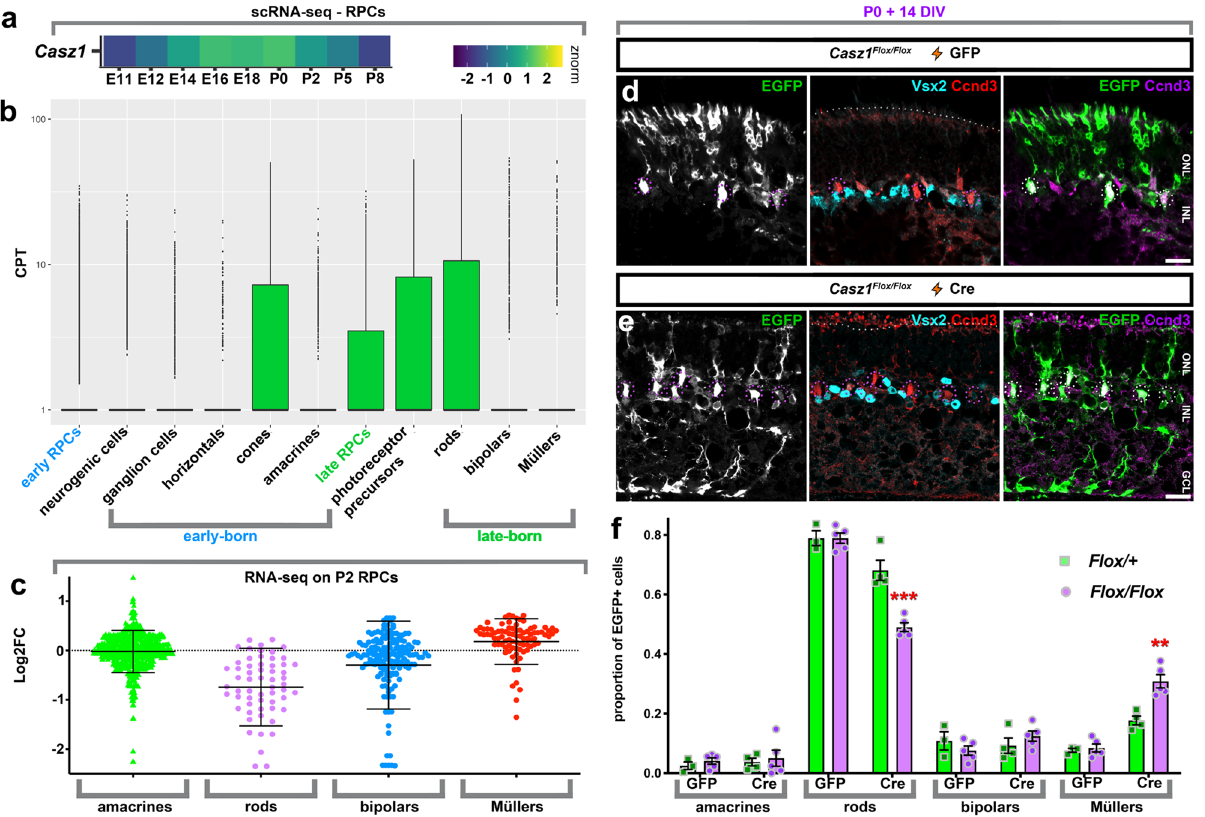
Figure 1. Casz1 controls the rod versus Müller glia fate decision in postnatal retinal progenitors. ( a,b ) reanalysis of scRNAseq expression data 3 . ( a ) Normalized Casz1 mRNA expression levels in RPCs during development. ( b ) Mean Casz1 mRNA expression (counts per 10 000 transcripts: CPT). ( c ) Re-analysis of previously published RNA-seq data from sorted P2 Casz1 cKO vs. control RPCs (n = 2) 13 . Plot depicts Log 2 fold-change in gene expression for cell subtype marker genes based on published cell-type -specific profiling 63, 64 . ( d,e ) P0 Casz1 Flox/Flox or Casz1 Flox/ + retinal progenitors were transfected with GFP control ( d )